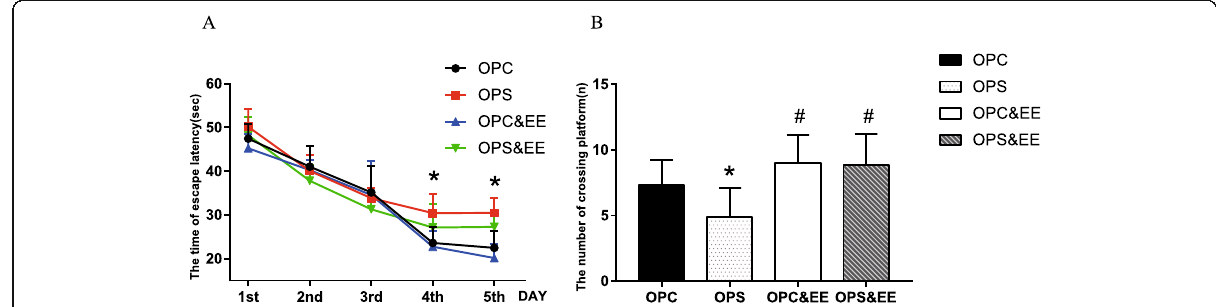
Fig. 5 The comparison among OPC, OPS, OPC&EE and OPS&EE in spatial learning and memory in MWM test. Differences in the time of escape latency and the number of crossing platform were detected among OPC, OPS, OPC&EE, and OPS&EE. The time of escape latency was shorten and the number of crossing platform were improved by enriched environment in the OPS. Data were respectively analyzed using repeated measure ANOVA, followed by LSD-t test to make comparison at the two different groups. Number of animals in each offspring group = 16 (50% male, 50% female). ( a The time of escape latency of the offspring in Morris water maze. b The number of crossing platform of the offspring in Morris water maze. * P < 0.05 vs. OPC. # P < 0.05 vs.